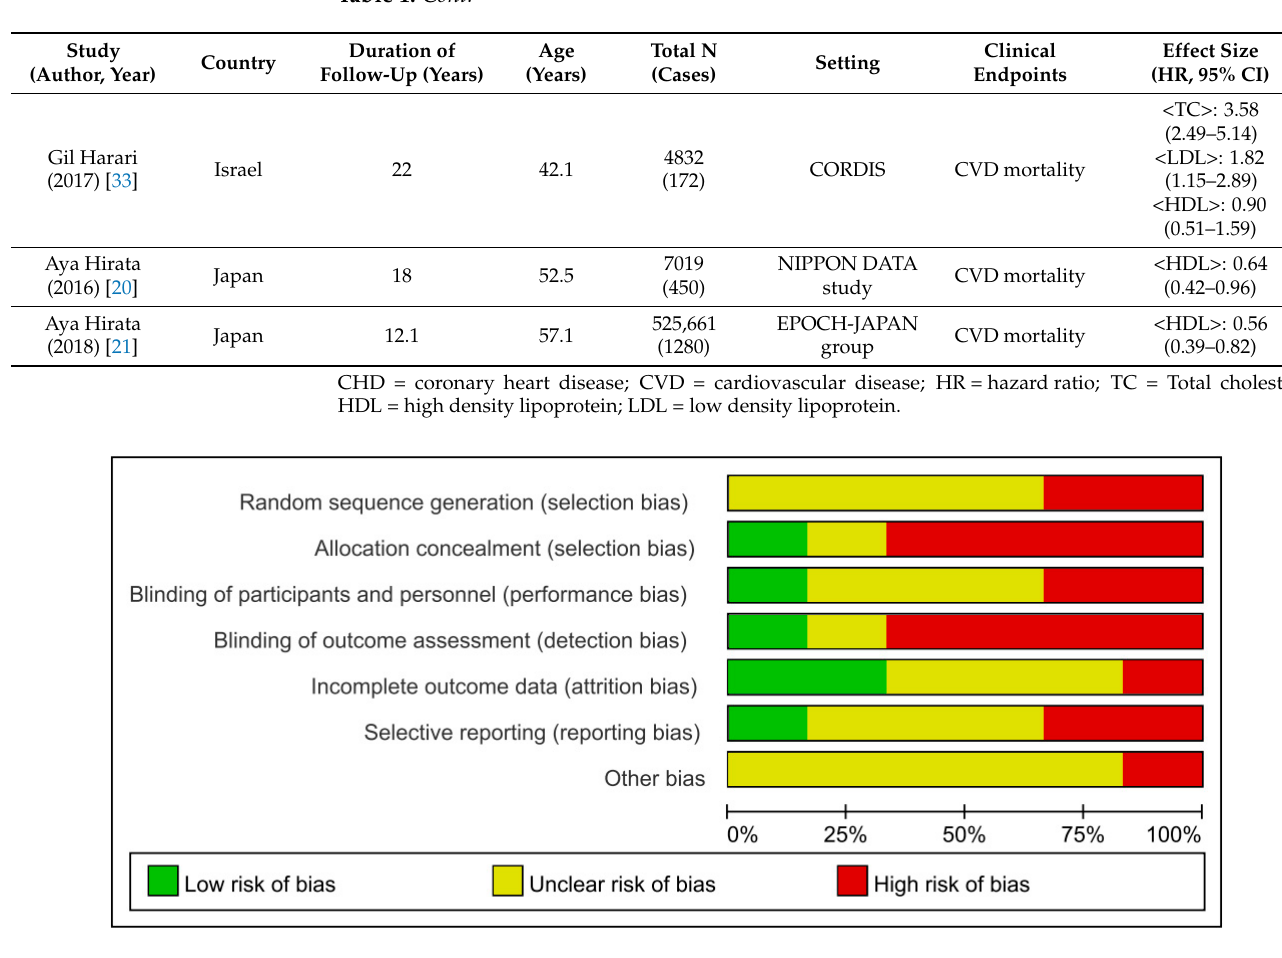
Figure 2. Cochrane Collaboration’s tool for assessing the risk of bias. Table 1. Characteristics of included cohort studies of serum cholesterol level and CVD mortality.